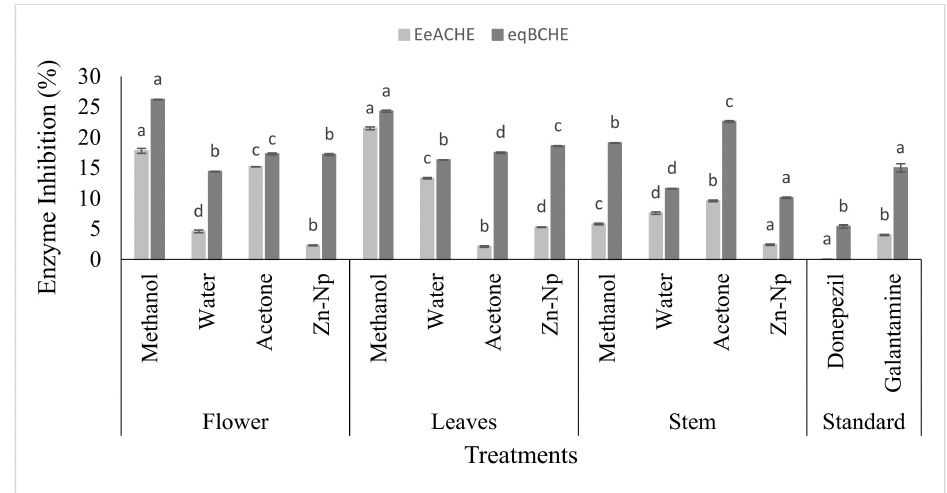
Figure 5. In vitro AChE and BChE inhibitory activities of Calotropis gigantea extracts and zinc nanopar- ticles. Bars with different letters are significantly different from each other ( p < 0.05).